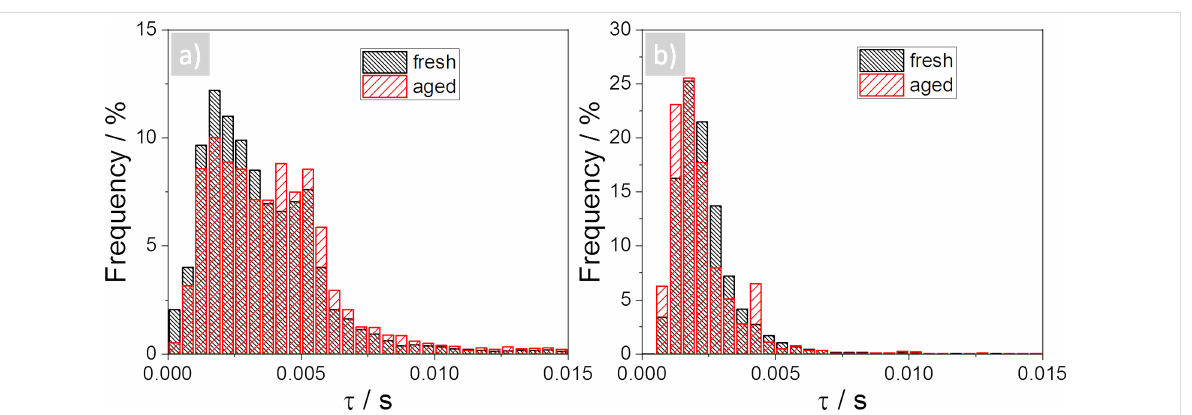
Figure 8: Comparison of time constants of the fresh and aged cathode, a) shows the time constants due to the positive and b) the negative dc-voltage